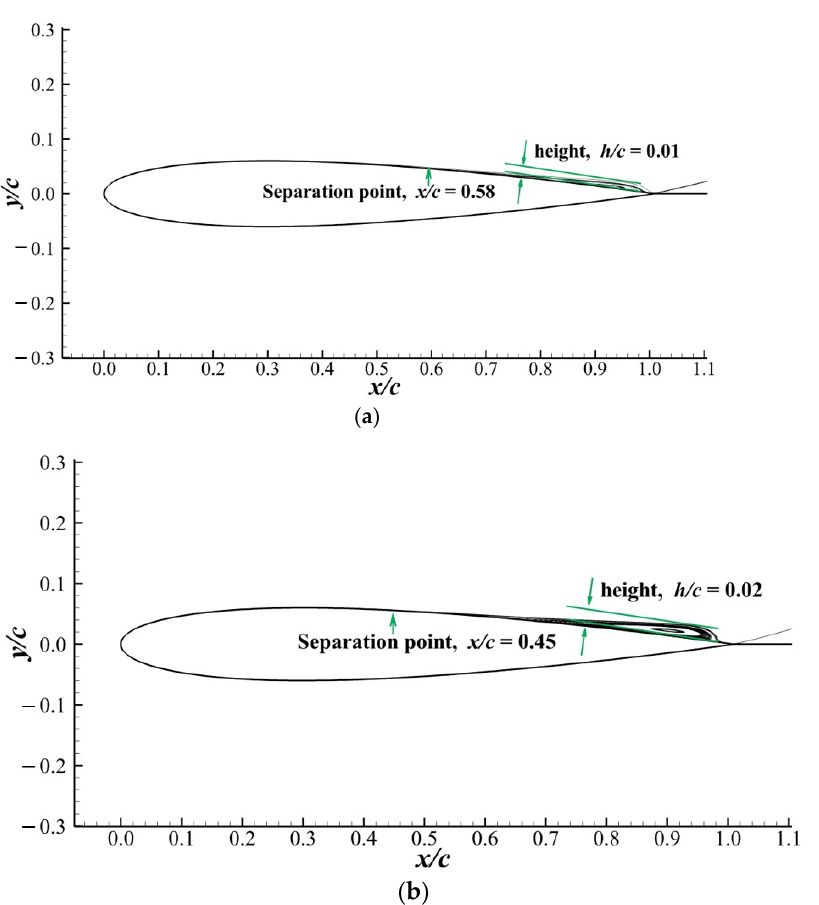
Figure 16. Separation bubble on the NACA0012 airfoil obtained by the SPF model with Re = 8.86 × 10 6 and Ma = 0.15. The separation point and the height of the separation bubble are marked on the figure. ( a ) AOA = 17 ◦ . ( b ) AOA = 18 ◦